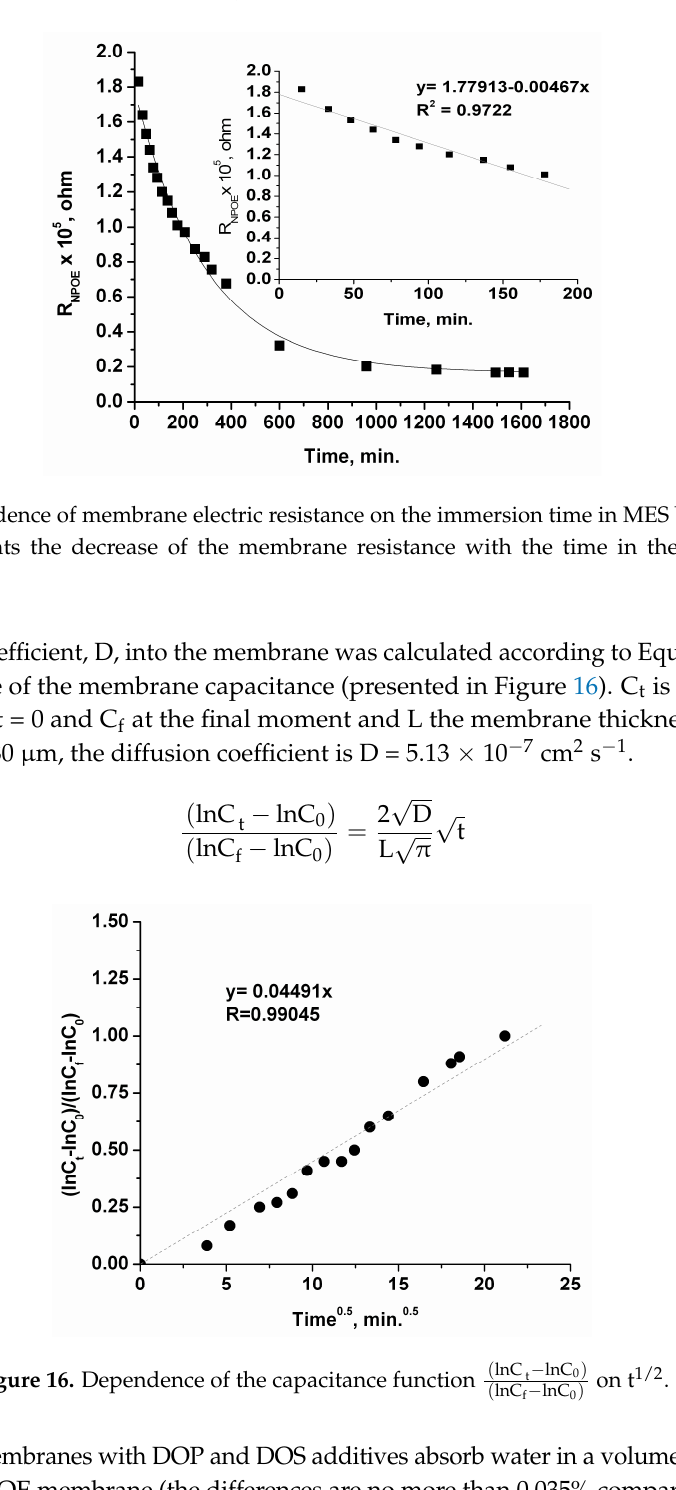
− lnC 0 ) ( lnC on t 1/2 . Figure 16. Dependence of the capacitance function on t 1/2 t ( lnC f − lnC 0 ) ( (